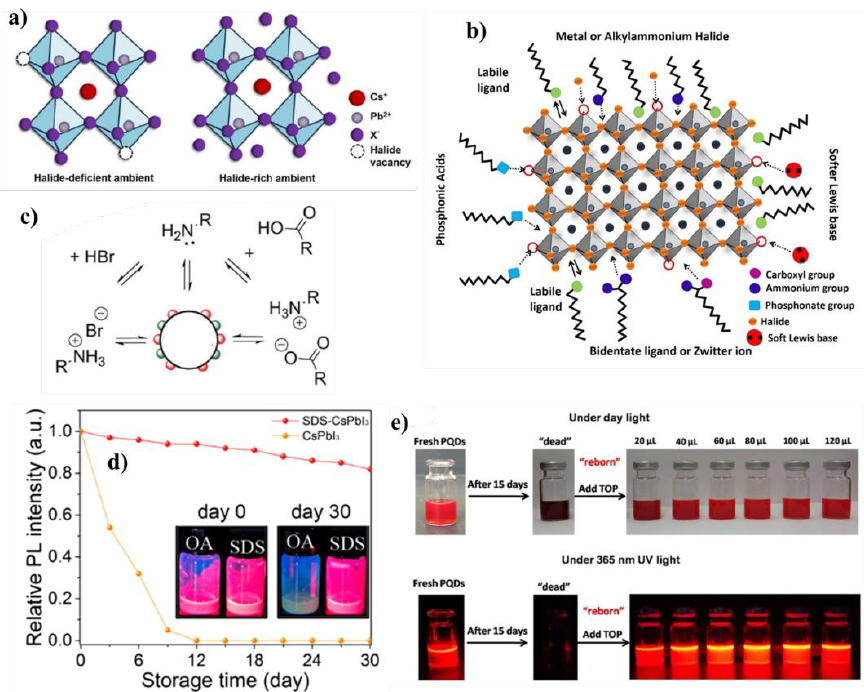
Figure 6. ( a ) Schematic representation of CsPbI 3 NCs in halide-deficient and halide-rich perovskite crystal; ( b ) Schematic depiction of surface passivation by capping ligands with different functional groups. ( a , b ) are adapted with permission from Ref. [98], Copyright 2019 American Chemical Society. ( c ) Schematic representation of the dynamic surface stabilization by oleylammonium bromide, oleylammonium oleate, and oleylamine. In addition, the relevant acid/base equilibria are depicted. Adapted with permission from Ref. [96], Copyright 2016 American Chemical Society. ( d ) Normalized PL intensity of CsPbI 3 NCs with time for both SDS-treated and untreated nanocrystals. Adapted with permission from Ref. [99], Copyright 2021 American Chemical Society. ( e ) Photographs of the quenched PL emission from CsPbI 3 NCs regained after the addition of the TOP ligand. Adapted with permission from Ref. [100], Copyright 2018 American Chemical Society.